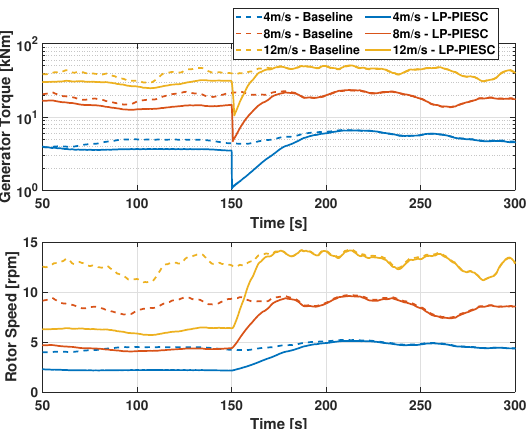
Figure 12. Effect of sudden change in torque gain with LP-PIESC on generator torque ( top ) and rotor speed ( bottom ) compared with the baseline (for hub height wind from Figure 6).